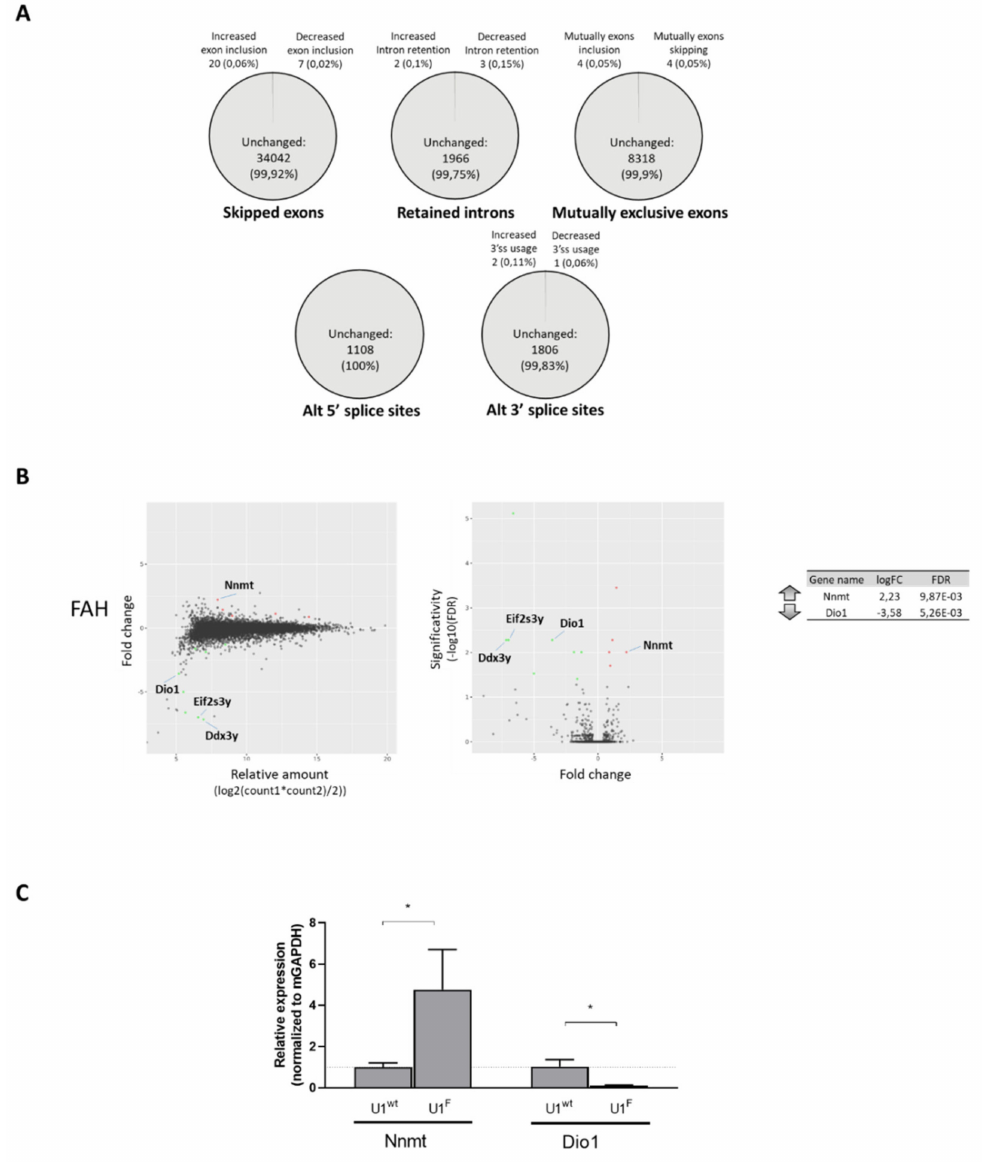
Figure 3. The compensatory U1 F does not have a widespread e ff ect on splicing and overall gene expression. ( A ) Fraction of each category (SE, RI, MXE, A5SS and A3SS) of Gencode-annotated splicing events showing increased or decreased alternative isoform use in hepatocytes from FAH5961SB mice treated with AAV8-U1 F as compared with those treated with AAV8-U1 wt . For each category, the number and the percentage (%) of events is indicated in the graph (FDR ≤ 0.05; Inclusion Level Di ff erence ≤− 0.2 or ≥ 0.2). ( B ) Comparison of the gene expression profile in hepatocytes from FAH5961SB mice injected with AAV8-U1 F as compared with those injected with the control AAV8-U1 wt . Only genes coding for proteins and having a fold change higher than two are shown. MA plot showing the relationship between the average expression value (on the X -axis) and the fold change ( Y -axis) for each gene in the genome (left panel). Volcano plot showing the relationship between the fold-change (on the X -axis) and the significance of the di ff erential expression test ( Y -axis) for each gene (middle panel). Black dots represent the genes that are not significantly di ff erentially expressed, while red and green dots represent the genes significantly UP- and DOWN-regulated, respectively. List of coding genes UP and Down regulated and mapping in autosomes (right panel). Only genes having a fold-change (FC) > 2 were reported. Adjusted p -values for multiple tests (by the Benjamini–Hochberg procedure) are reported as “false discovery rate” (FDR) value. ( C ) Validation of RNAseq data by qPCR. Histograms report the relative gene expression ± standard deviation (SD) from three independent experiments, normalized for the house keeping mouse GAPDH